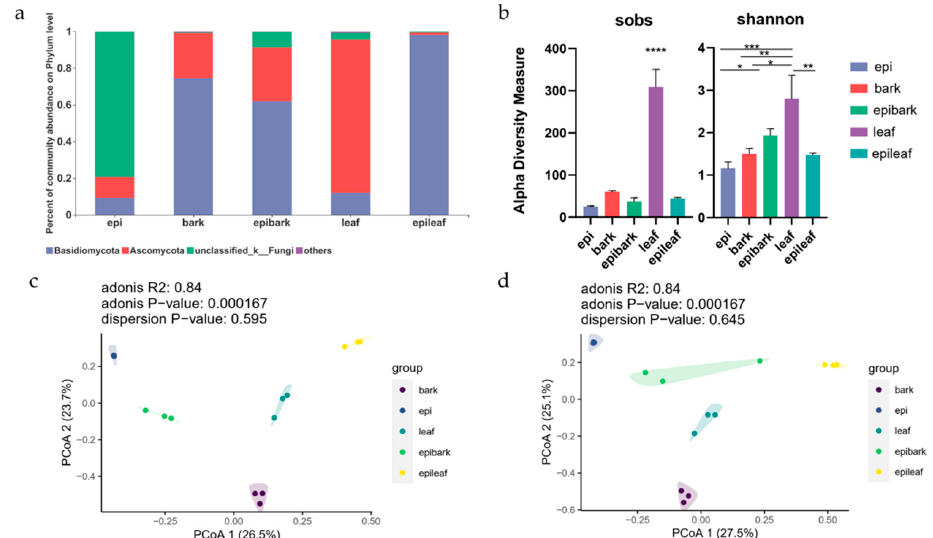
Figure 2. Fungal community compositions of protocorms and substrates at the phylum level ( a ); alpha diversity of fungal OTUs ( b ); principal coordinate analysis (PCoA) plots of fungal community structures at the genus level ( c ) and family level ( d ) based on the Bray-Curtis distance matrix. epi: protocorms in vitro germinated on MS1 medium; bark: pine bark substrate; epibark: protocorms ex situ germinated on pine bark; leaf: rotten oak leaf substrate; epileaf: protocorms ex situ germinated on rotten oak leaf. * p < 0.05; ** p < 0.01, *** p < 0.001; **** p < 0.0001